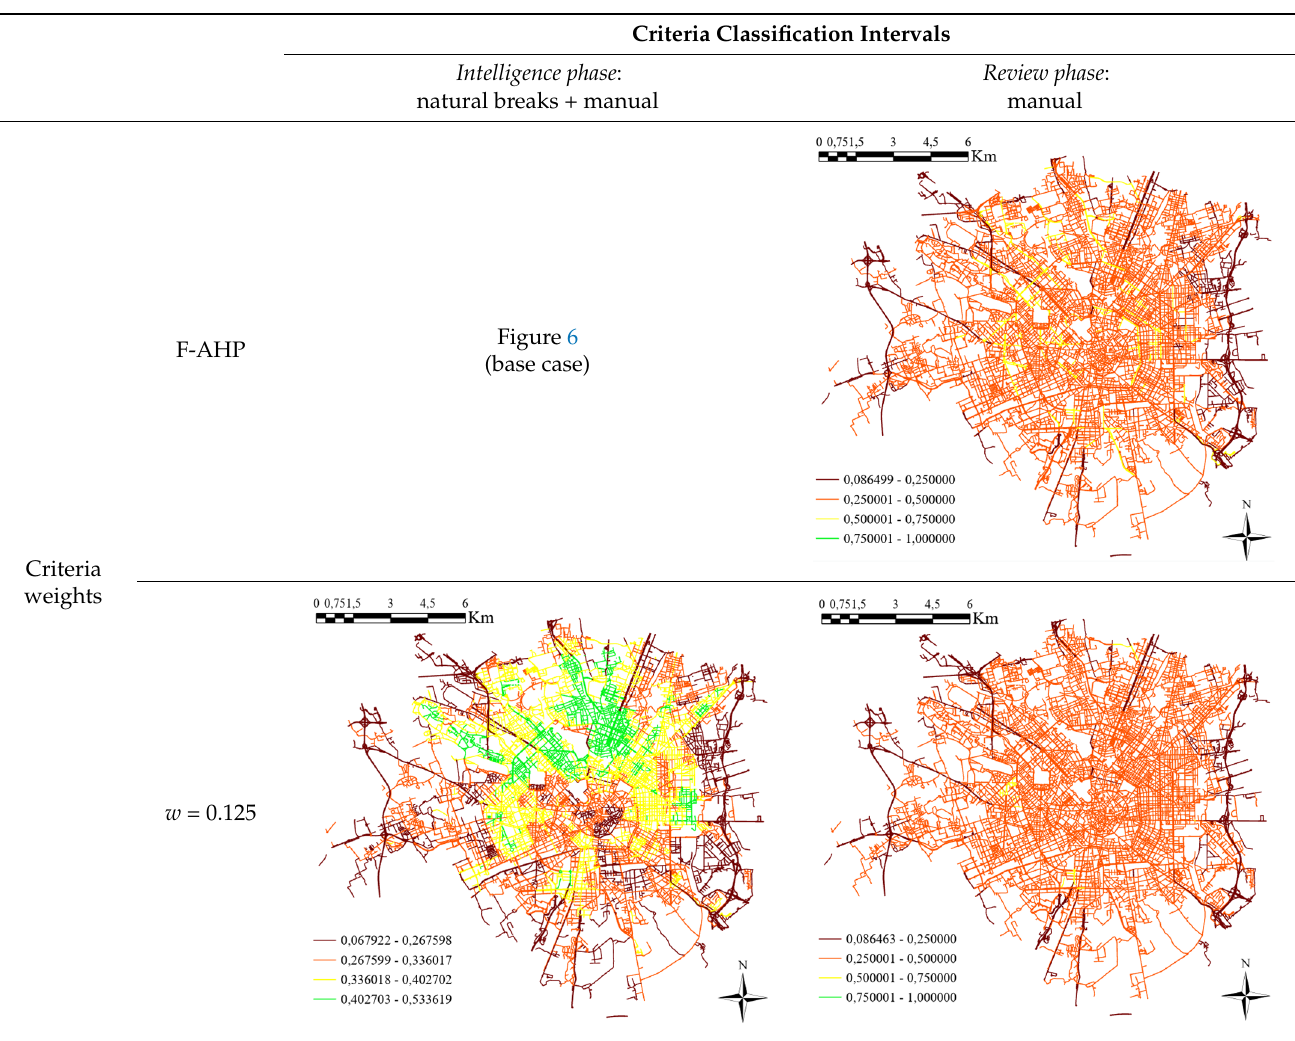
Table 8. Final maps of the city of Milan with the indication of Feasibility Index in different